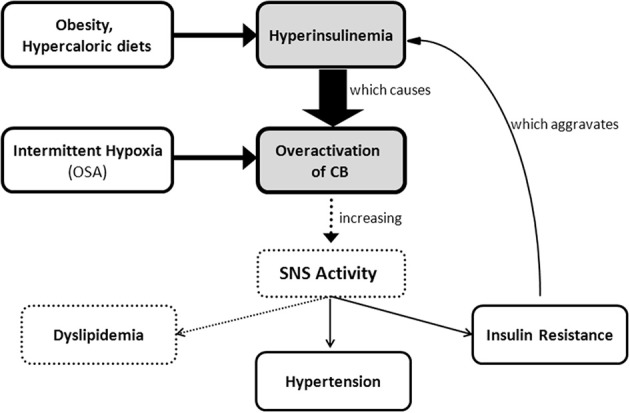
Schematic representation of carotid body involvement in the development of insulin resistance through an increase in sympathetic nervous system activity. Overactivation of the carotid body caused by hyperinsulinemia and/or by chronic intermittent hypoxia originates an increase in sympathetic nervous system activity that promotes insulin resistance, hypertension, and probably dyslipidemia.